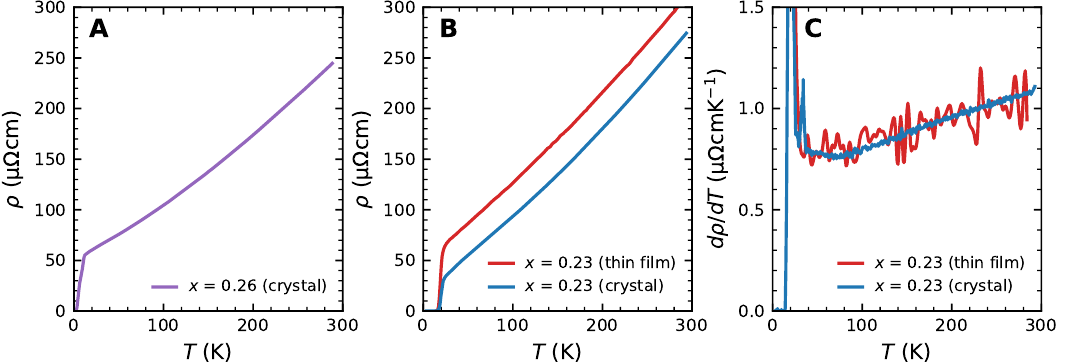
≈ 5 K). Note that the c = 50 µ Ω cm. B) : Comparison of the in-plane 0 ( T ) data for the thin film has been divided ab values are 20 and 50 0 / dT of the same (normalized) ab